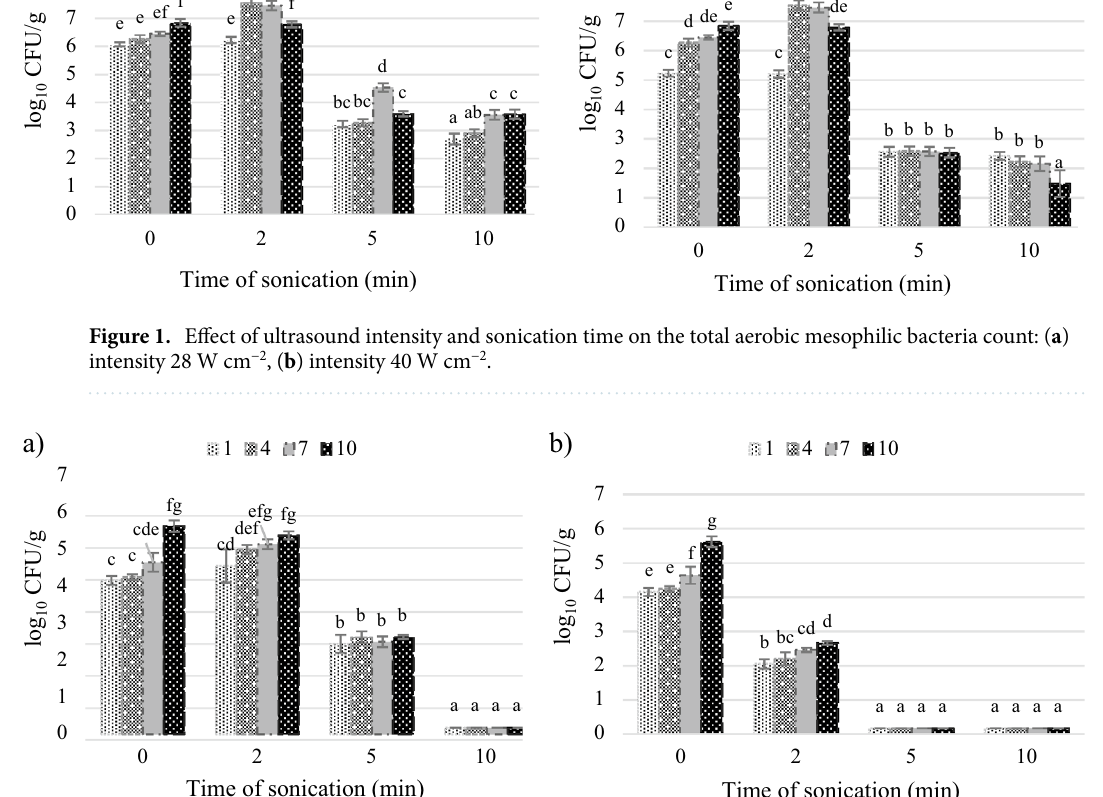
Figure 2. Effect of ultrasound intensity and sonication time on lactic acid bacteria count: ( a ) intensity 28 W cm −2 , ( b ) intensity 40 W cm −2